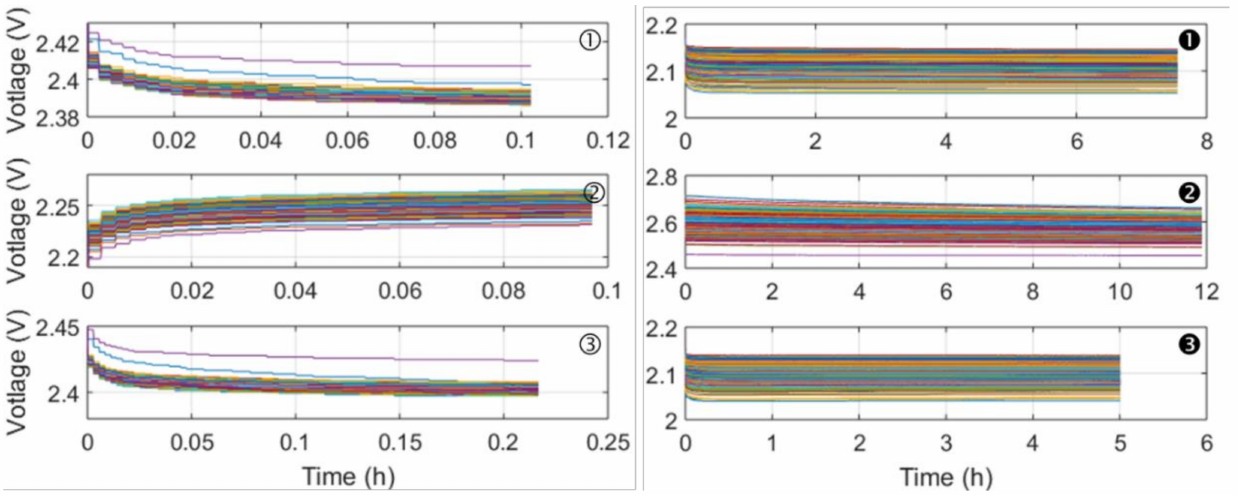
Figure 7. Example of relaxation vs. time curves for the manufacturer test ( 1 (cid:13) – 3 (cid:13) ) and HNEI test (